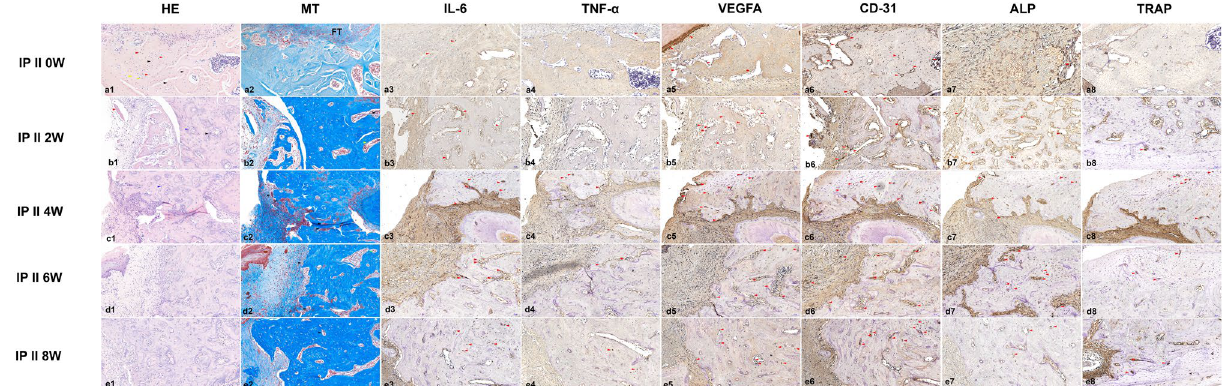
Figure 8. Representative histological and immunohistochemistry images from IP BRONJ model group II at ×20 magnification, 50 μm. In representative slide images taken at 0 weeks post-extraction, the bone was dominated by healthy osteocytes (red arrowheads), with some pyknotic osteocytes (yellow arrowheads) and empty lacunae (black arrowheads) also visible ( a1 ). The MT-stained slide shows the bone adjacent to the fibrous tissue ( a2 ). In the H&E-stained slide, 2 weeks post-extraction, the bone area was dominated by healthy osteocytes, with some pyknotic osteocytes and empty lacunae. In addition, a thinner reversal line was observed compared with group I (blue arrowheads), intact osteoclasts in the sealing zone (black arrowheads) and small sequestrum (red arrowheads) are also visible ( b1 ). In the MT-stained slide, an osteoblast (yellow arrowhead) and vital blood vessel (black arrowhead) are visible ( b2 ). In the H&E-stained slide at 4 weeks post-extraction, the bone area was dominated by healthy osteocytes with some empty lacunae. A reversal line (blue arrowhead) was also observed, ×20 magnification, 50 μm ( c1 ). Intact osteoclasts in the sealing zone (black arrowheads) and a detached osteoclast with a wide Howship’s lacuna from the bone (green arrowhead) are visible ( c2 ). At 6 weeks post-extraction, the bone area was dominated by healthy osteocytes, with some pyknotic osteocytes and empty lacunae, ×20 magnification, 50 μm ( d1 ). Intact osteoclasts in the sealing zone (black arrowheads) and a detached osteoclast with a wide Howship’s lacuna from the bone (green arrowhead) are visible ( d2 ). At 8 weeks post-extraction, the bone area was dominated by healthy osteocytes, with some pyknotic osteocytes